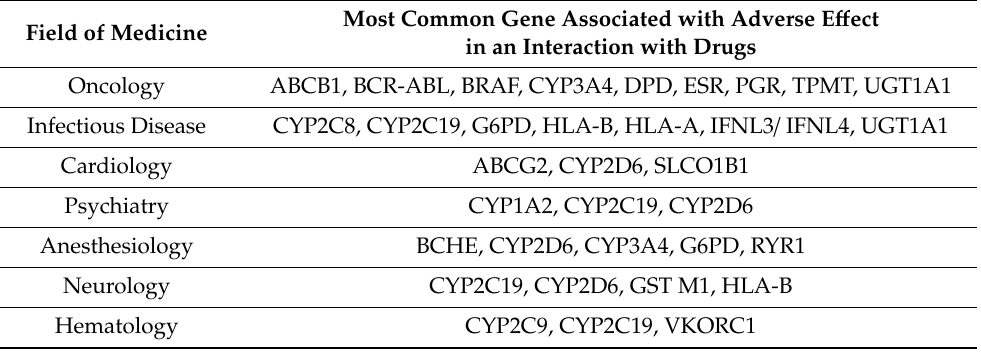
Table 1. Most common genes associated with adverse e ff ect of drugs among di ff erent fields of medicine.